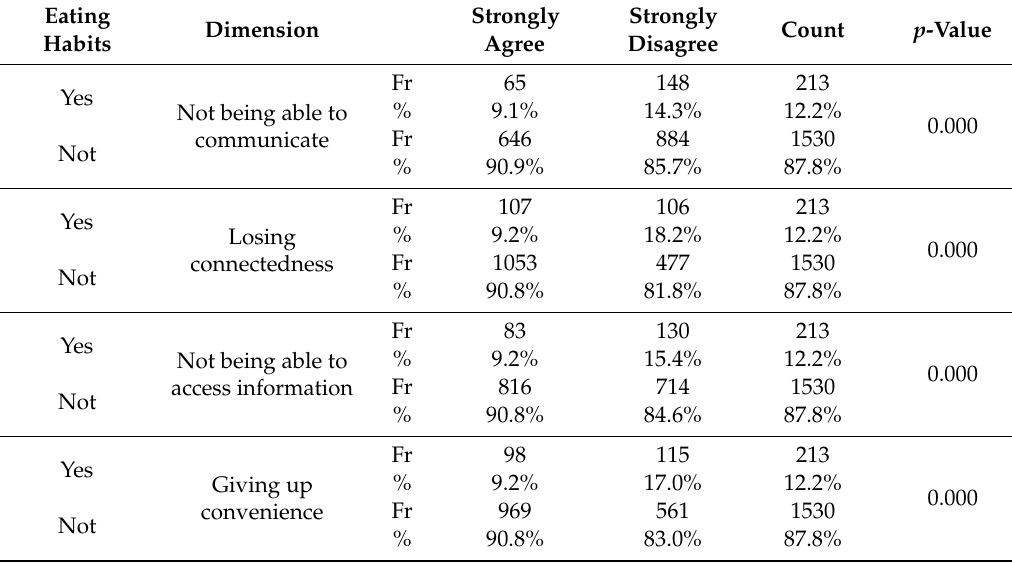
Table 7. Cross table and Chi-square